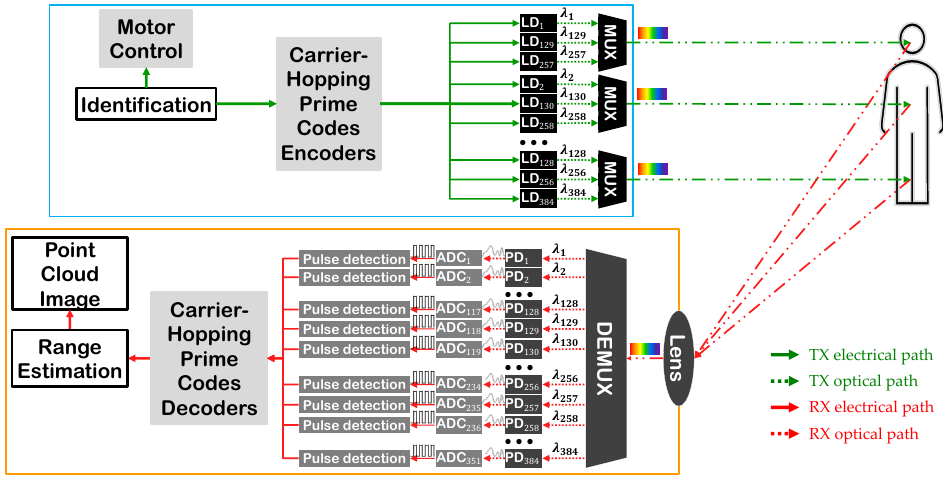
Figure 7. The architecture of the concurrent firing LIDAR scanner.